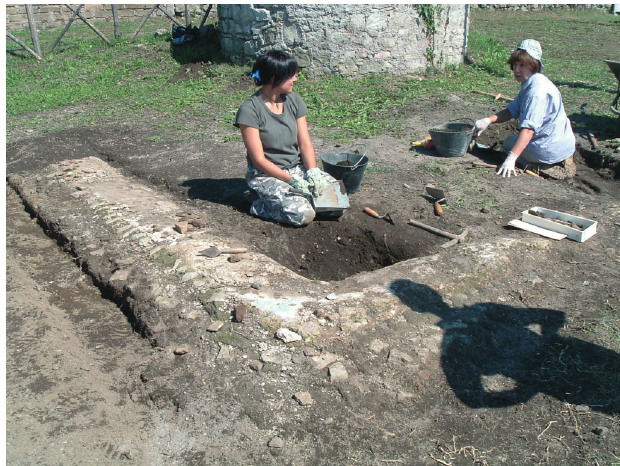
Fig. 9. Results of the September 2005 excavation. The wall of an ancient room are very evident in the picture. Following digging revealed that the room is filled with roofing material, as the authors presumed.